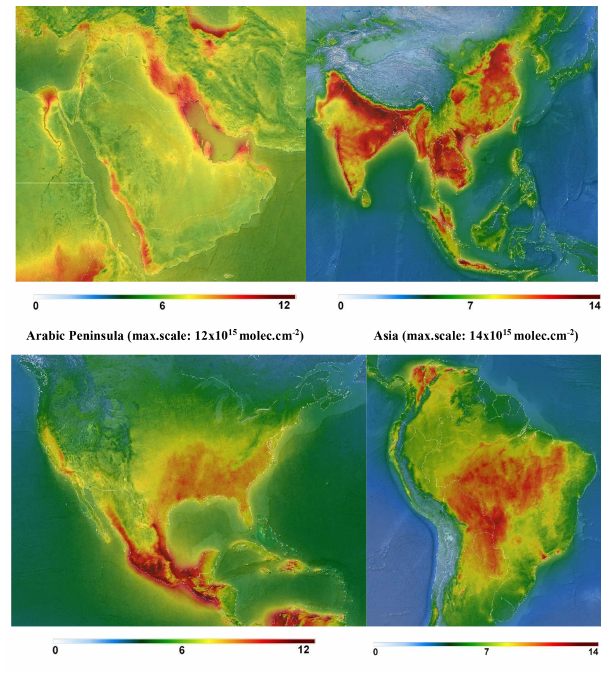
Figure 2. Multi-annual regional maps of TROPOMI HCHO tro- pospheric columns (March 2018–February 2021), on a spatial grid of 0.05 ◦ in latitude and longitude. Observations are filtered using the qa_values > 0.5. Modified Copernicus Sentinel-5P satellite data, OFFL L2 HCHO product, BIRA-IASB/DLR/ESA/EU.